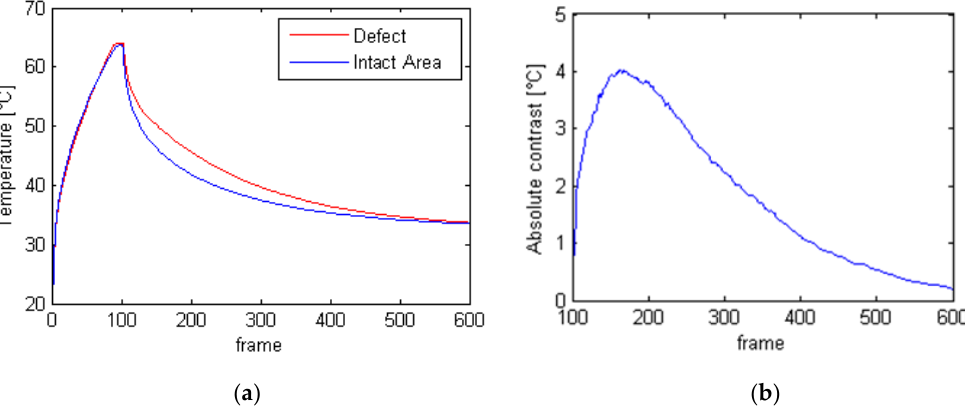
Figure 7. ( a ) Map of isotherms at the beginning of the cooling phase for artificial Plate I and ( b ) defect presence example on raw thermal image, using heating time of 20 s.